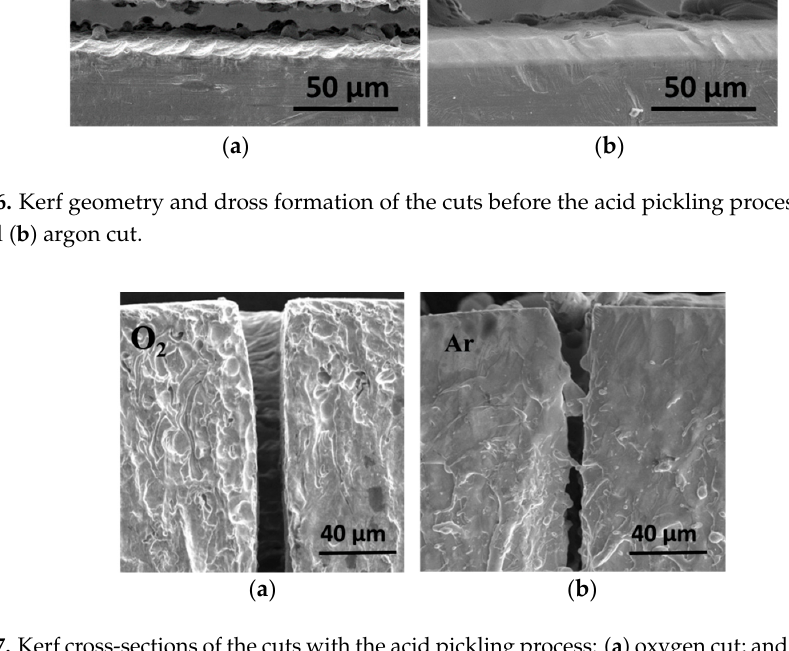
6 of 12 Figure 4. ( a ) The image of the oxygen cuts with acid pickling; ( b ) energy dispersion spectrum (EDS). Figure 5. ( a ) The image of the argon cuts with acid pickling; ( b ) energy dispersion spectrum (EDS). The energy dispersion spectrum (EDS) results of the cuts processed with acid pickling are also shown in Tables 3 and 4. For the oxygen cuts, the content of Cr and oxygen decreased remarkably. For the argon cuts, the elements composition was similar to the original surface. Chromic oxide is easy to dissolve in acid, and it could then be concluded that the particles on the oxygen cuts surface are oxides. Thereby, the dross formation on the oxygen cuts was easily removed by the acid pickling process. However, the acid pickling process had a limited influence on the argon cuts surface, and the dross formation was not eliminated. 3.1.3. Kerf Geometry and Dross Formation